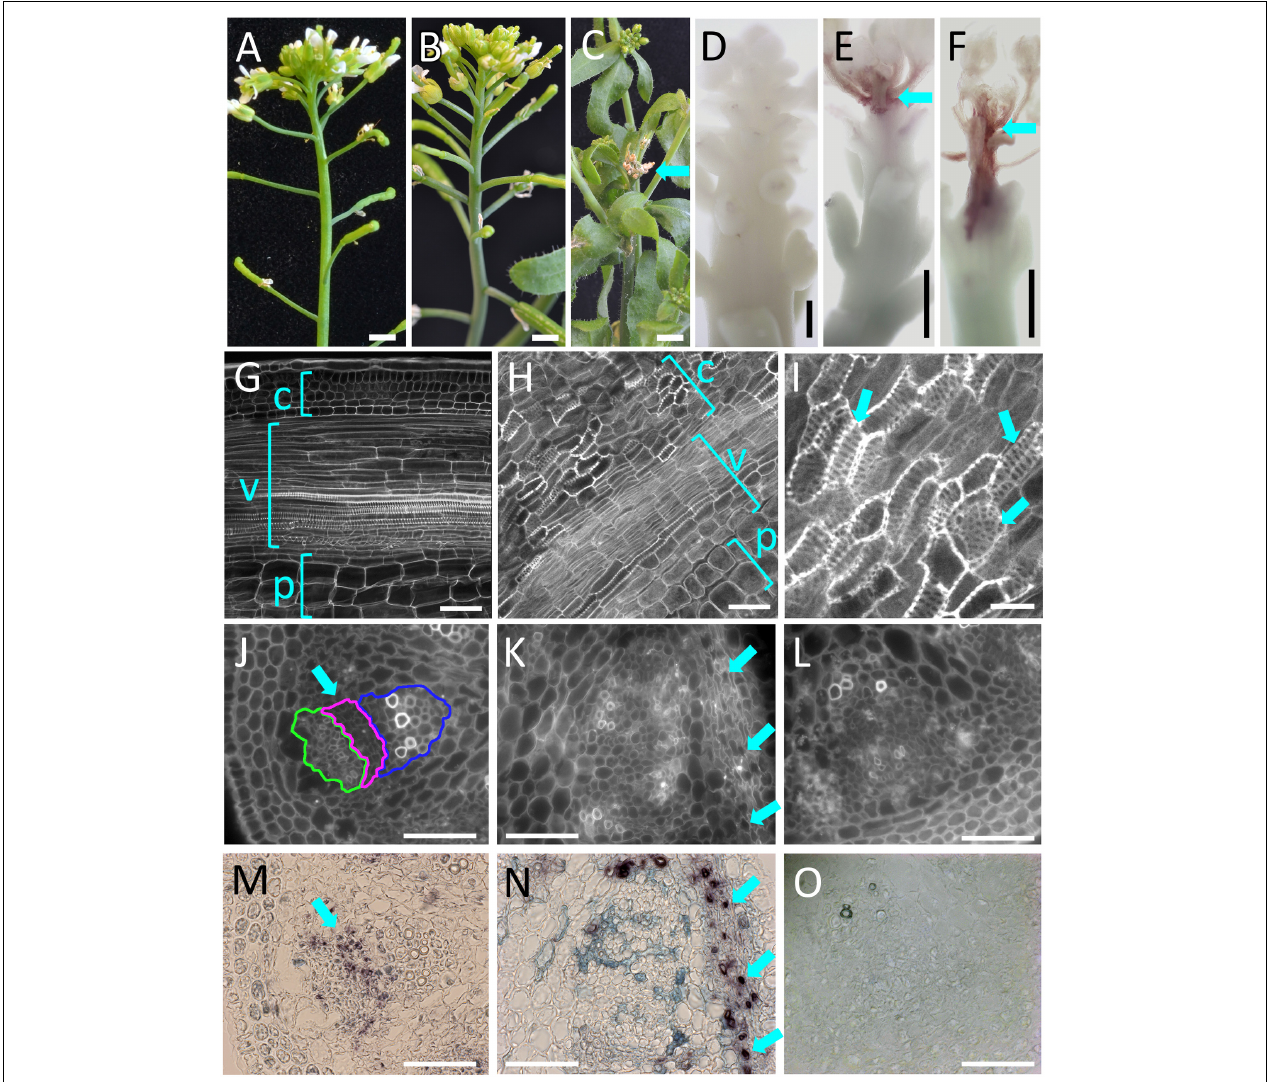
FIGURE 5 | PLL12 over-expression induces ectopic xylem differentiation and expression of a cambium marker. (A–C) : Mock-treated RPS5A:LhGR,pOp:PLL12 (A) looked normal, whilst induction of PLL12 expression with dexamethasone resulted in mild [ (B) , shortened internodes] to severe effects [ (C) , with death of the stem apex (arrow) and lateral organs]; scale bars: 2 mm. (D–F) : Mock-treated (D) or dexamethasone-treated (E,F) inflorescence apices of RPS5A:LhGR, pOp:PLL12 plants stained with phloroglucinol, showing mild (E) to severe (F) lignification; scale bars: 400 µ m. (G–I) : Confocal images of RPS5A:LhGR:PLL12 stem apices stained with mPS-PI after mock-treatment (G) or dexamethasone treatment (H,I) ; c, v, and p indicate cortex, vasculature and pith; (I) higher magnification of stem section similar to panels (H) , with arrows indicating cells with the pitted walls characteristic of xylem elements and the top left arrow marking an opening between adjacent pitted cells. Scale bars: 50 µ m (G,H) , 20 µ m (I) . (J–O) : In situ hybridisation experiments showing PXY expression after mock (J,L,M,O) or dex-treatment (K,N) of RPS5A:LhGR:PLL12 stem apices. All sections were incubated with PXY anti-sense probe except (L,O) (sense probe controls). (J–L) calcofluor images of the corresponding images shown in panels (M–O) respectively; in panel (J) , phloem, cambium and xylem regions are enclosed in green, magenta and blue lines, respectively. The normal PXY expression pattern in the cambial and early xylem precursor cells [arrows in panels (J,M) ] is disrupted after dexamethasone treatment, which also induces strong PXY expression in a subset of cortical cells [arrows in panels (K,N) ]. Bars: 50 µ